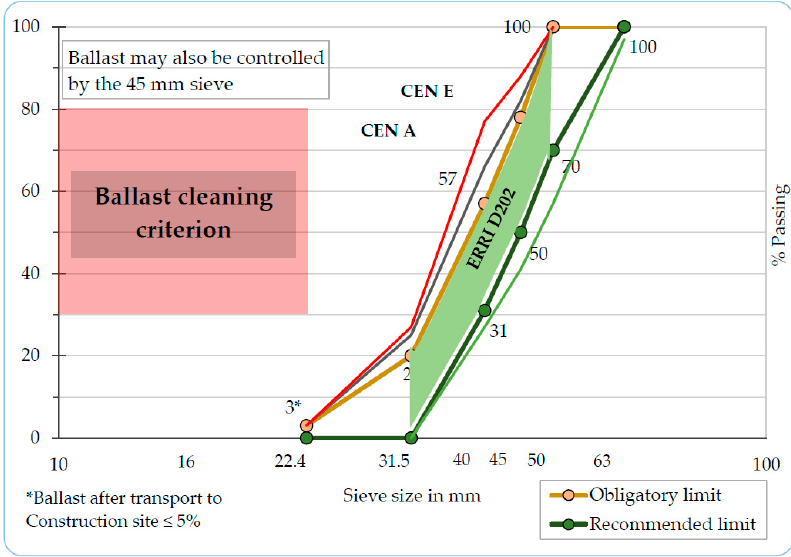
Figure 2. European Rail Research Institute (ERRI) ballast specification [8].